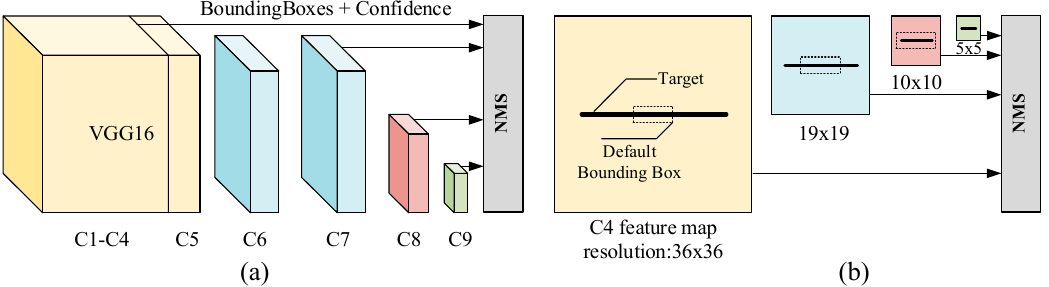
Figure 1. ( a ) Single shot multibox detector (SSD) architecture. From the convolutional layers C1 to C9, a number of bounding boxes and their corresponding confidence are inferred. ( b ) Fixed size default bounding box on different resolution feature maps. The fixed size default box captures different-sized targets in different resolution feature maps. This architecture allows the SSD to capture both large and small targets in one shot.